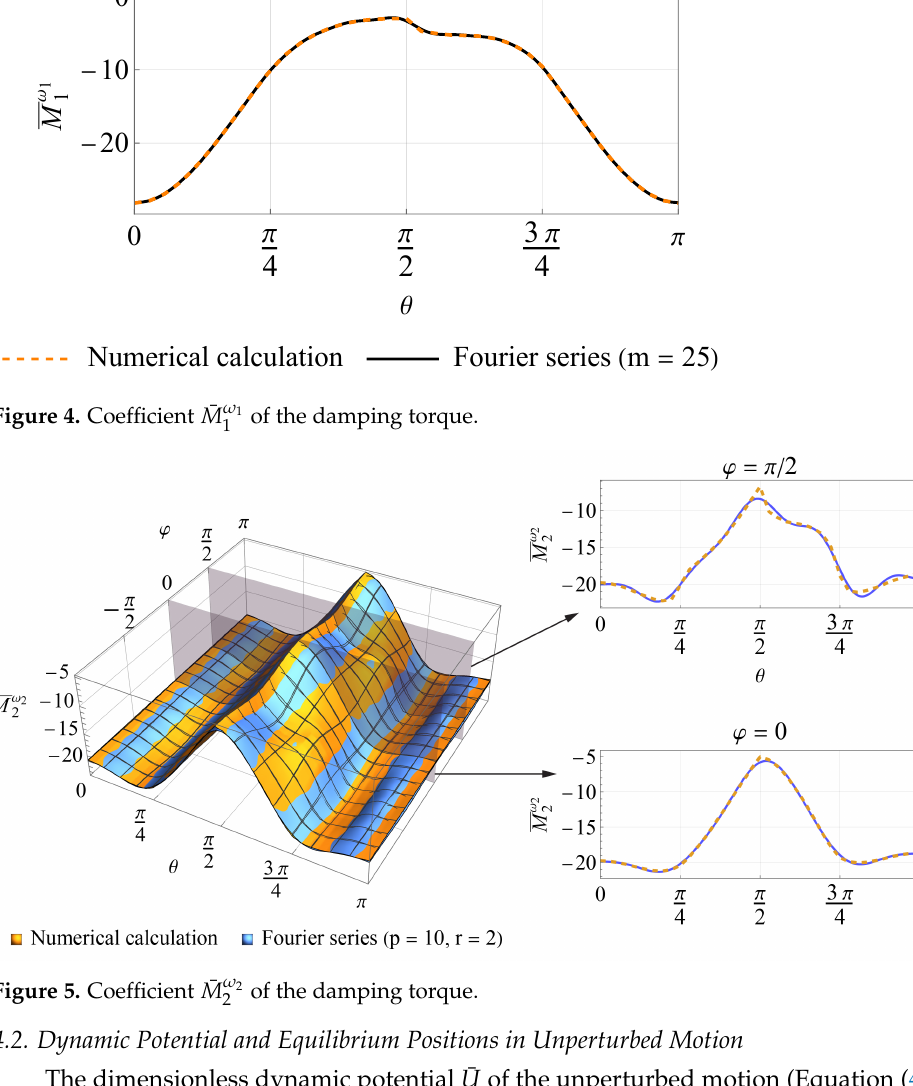
of the damping 2